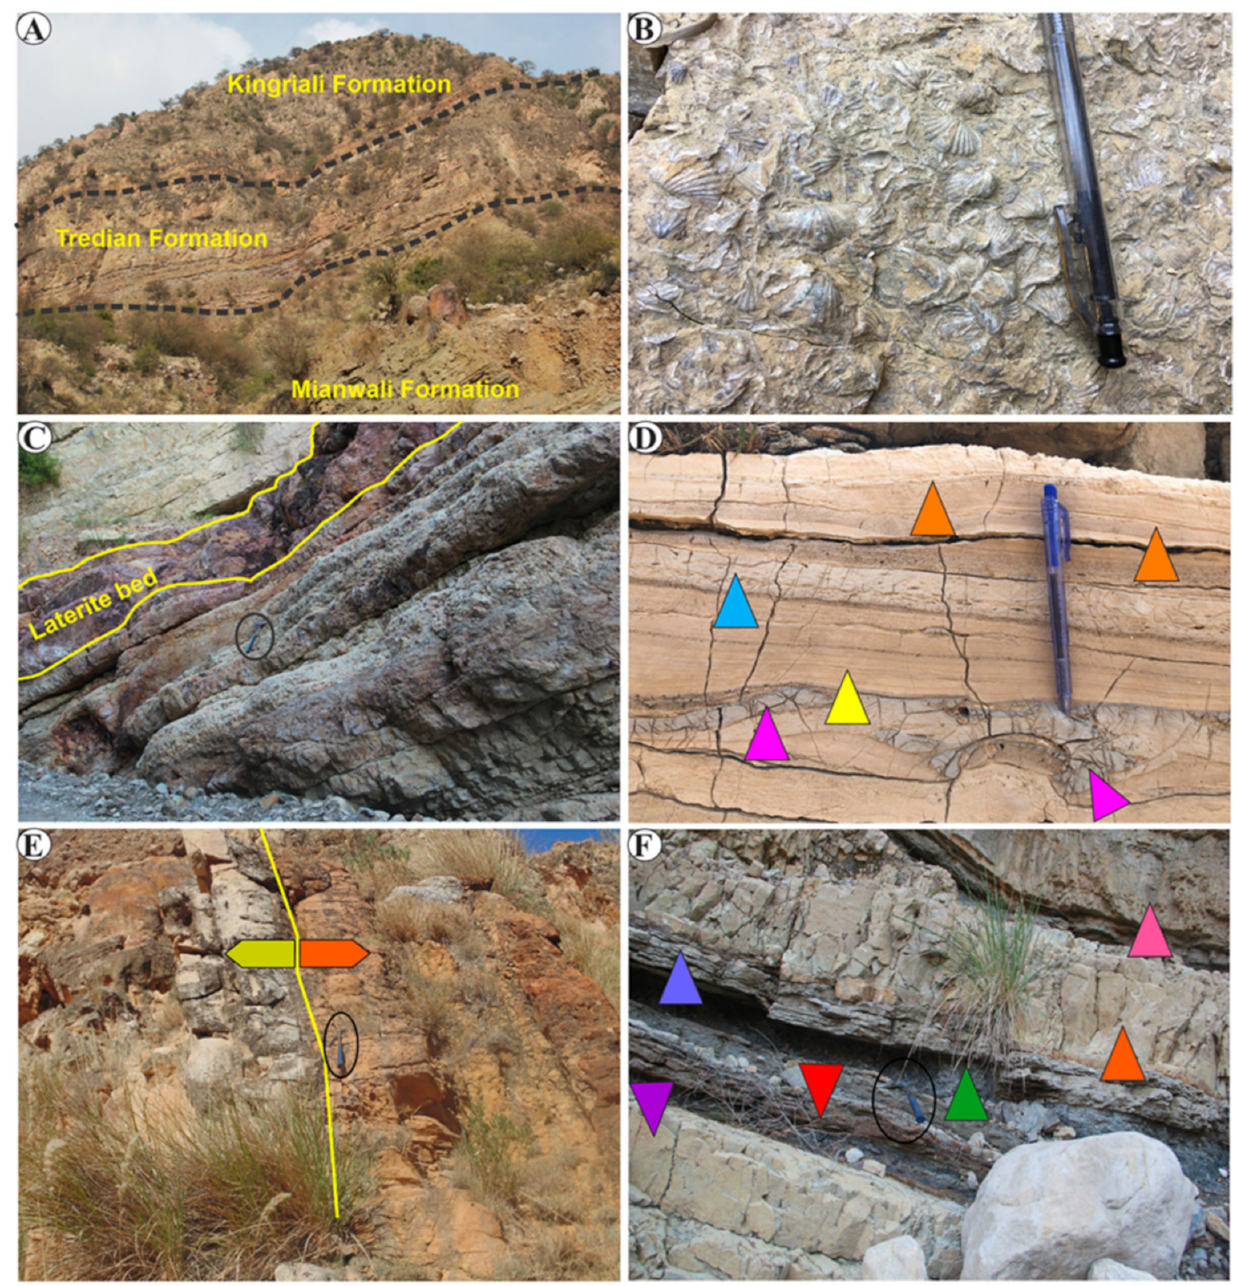
Figure 2. Field images of the Kingriali Formation showing key depositional and diagenetic char- acteristics. ( A ) Field view of the Kingriali Formation in Surghar Range. ( B ) Field detail of the Kingriali Formation showing the presence of abundant shallow marine bivalves. ( C ) Laterite bed exposed in the lower part of the Kingriali Formation, indicating sub-aerial exposure. ( D ) Field view of the Kingriali Fm showing lensoidal sandy facies (yellow arrows), evaporites (pink arrows), partially replaced mud dominated facie of the host limestone (blue arrow) and thin dolomitized bed (orange arrows). ( E ) Orange arrow points towards the dolomite beds at the lower contact of Kingriali Formation (lying exactly above the white sandstone beds of Tredian Formation (greenish yellow arrow). ( F ) Mud dominated facies (purple arrow) is overlain by laterite bed (red arrow). Green arrow indicates glauconitic shales which is overlain by dolomitic shale (blue arrow), partially replaced grain dominated limestone bed (orange arrow) and completely replaced bioclastic rich dolostone (pink arrow) bed of the investigated